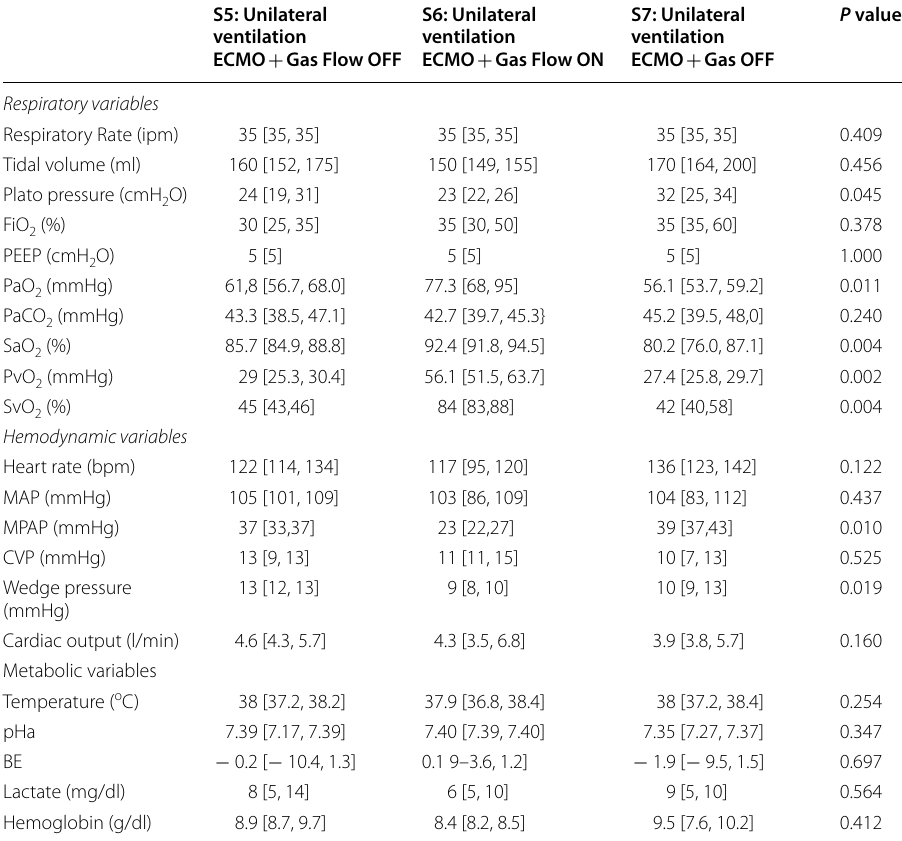
SvO 2 denotes venous oxygen saturation acquired in the Pulmonary Arterial Catheter; PaO 2 and PvO 2 denotes arterial and venous oxygen partial pressure, respectively; PaCO 2 denotes arterial carbon dioxide partial pressure; SaO 2 denotes arterial oxygen saturation; MAP denotes mean arterial pressure; MPAP denotes mean pulmonary arterial pressure; CVP denotes central venous pressure; and BE denotes Base